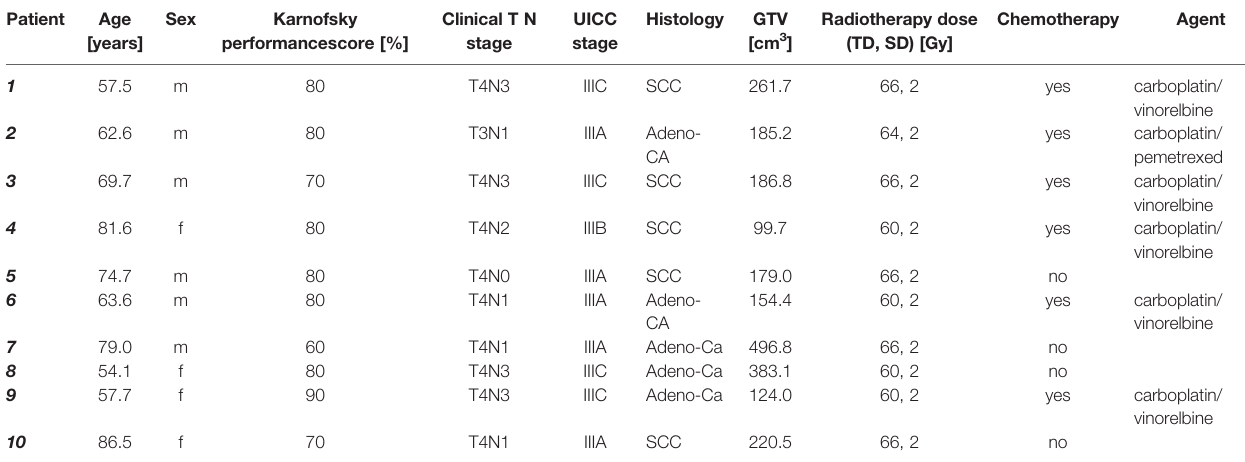
TABLE 1 | Patient and treatment